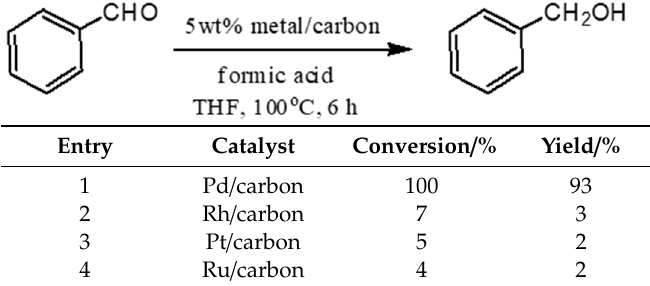
Table 1. Reaction of Benzaldehyde with formic acid using carbon-supported metal catalysts.